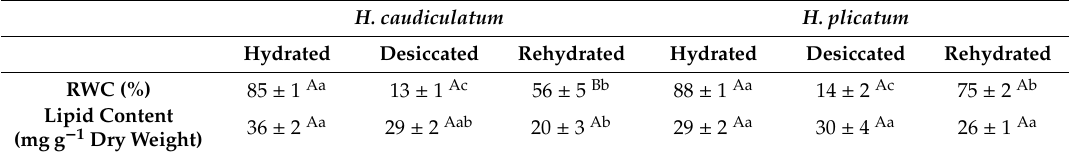
Table 1. Changes in relative water content (RWC) and lipid content during the three stages of a desiccation–rehydration cycle (hydrated, desiccated, rehydrated) in two filmy ferns species with contrasting desiccation tolerance: Hymenophyllum caudiculatum , less desiccation tolerant and Hymenophyllum plicatum , more desiccation tolerant.